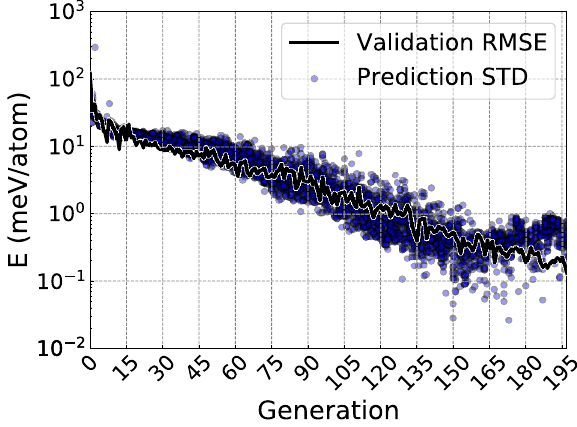
Fig. 9 Performance of the crystal fi ngerprint descriptors during the evolutionary process. Results shown for □ O in anatase TiO 2 . Bold black lines represent the calculated root mean square errors. Blue dots represents the values of the prediction standard error. Each generation corresponds to 20 fi tness-function